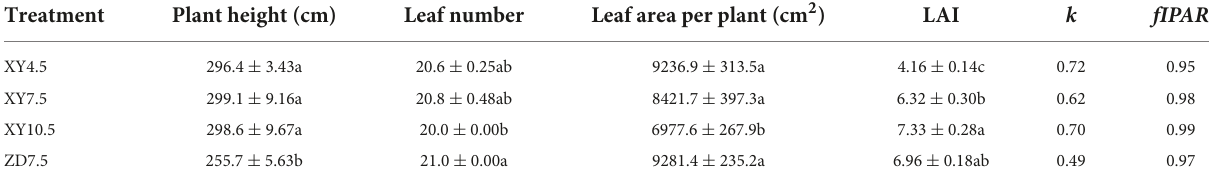
TABLE 1 Phenotypic traits, light extinction coefficient and fraction of intercepted PAR (f IPAR ) of maize canopy for different treatments. Treatment